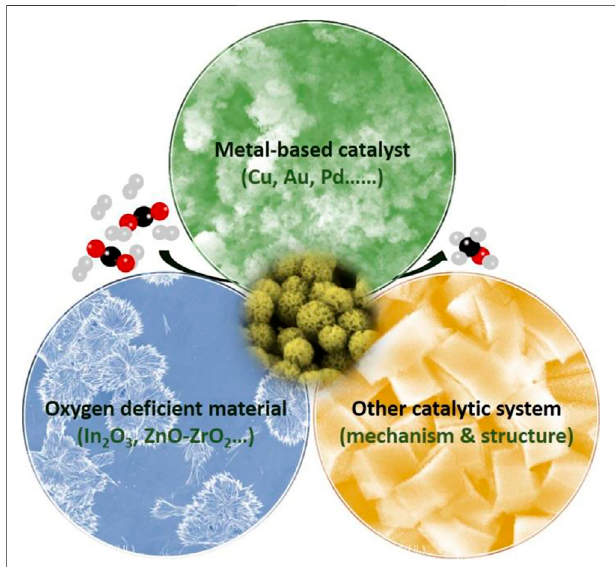
FIGURE 7 | Heterogeneous catalysts for methanol synthesis from CO 2